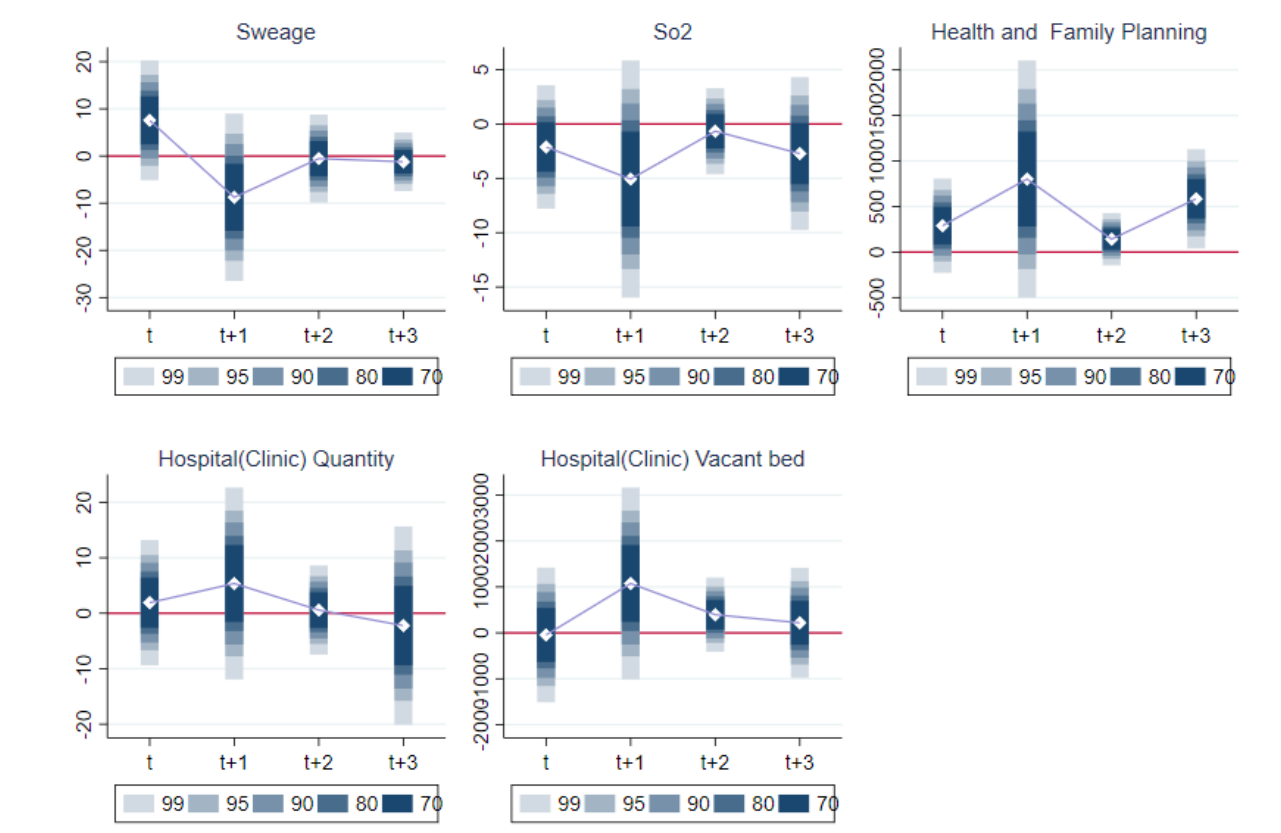
Figure 3. Trend dynamic graph.